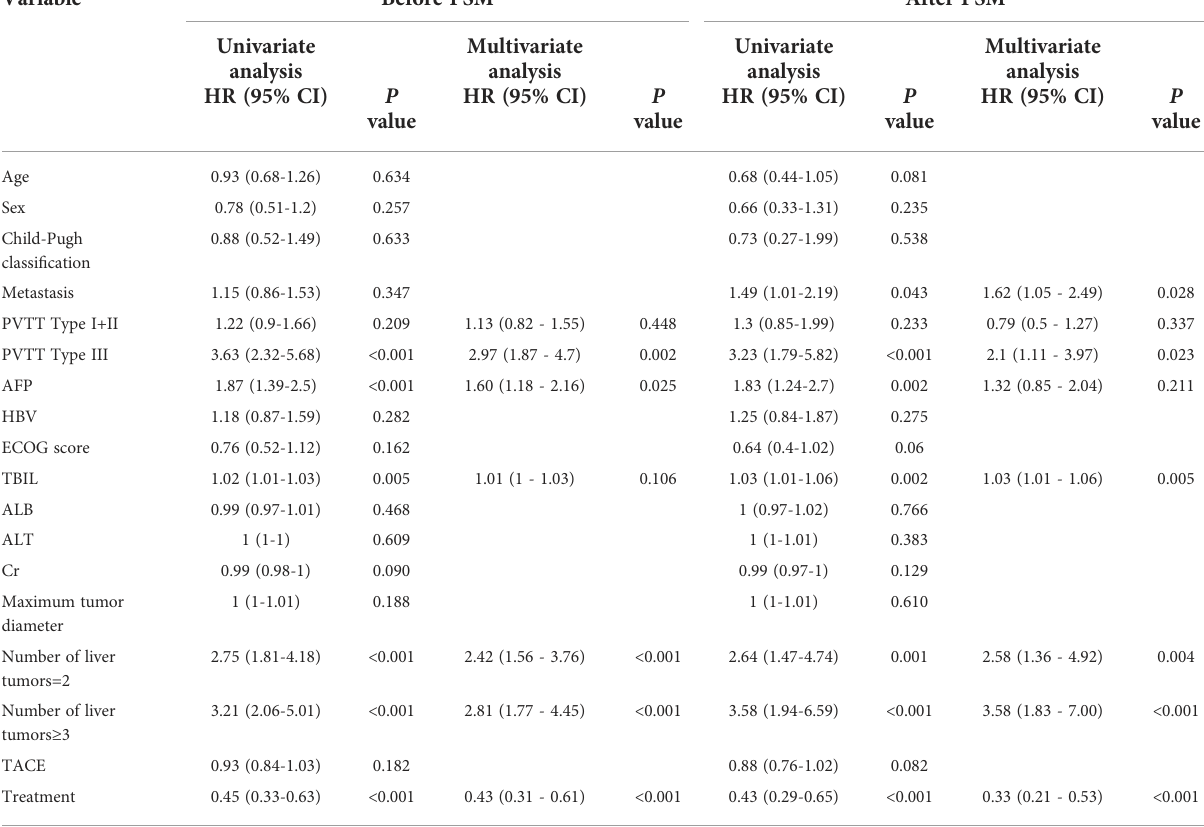
TABLE 3 Univariate and multivariate Cox proportional hazards regression model analysis of OS before and after PSM.